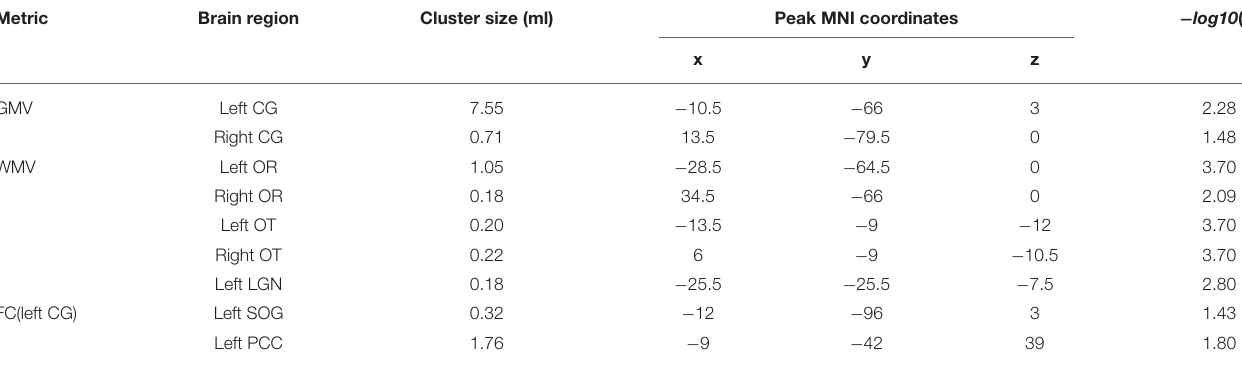
p values are corrected using TFCE-FWE method. FC, functional connectivity; CG, calcarine gyrus; FEW, family-wise error; GMV, gray matter volume; HC, healthy controls; LGN, lateral geniculate nucleus; LHON, Leber hereditary optic neuropathy; OR, optic radiation; OT, optic tract; PCC, posterior cingulate cortex; SOG, superior occipital gyrus; TFCE, threshold-free cluster enhancement; WMV, white matter